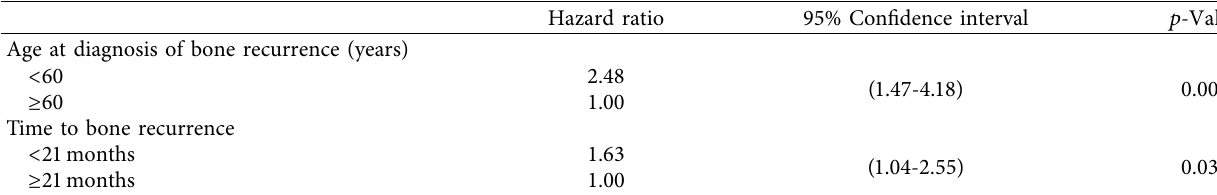
Table 3: Multivariable clinical prognostic factors for overall